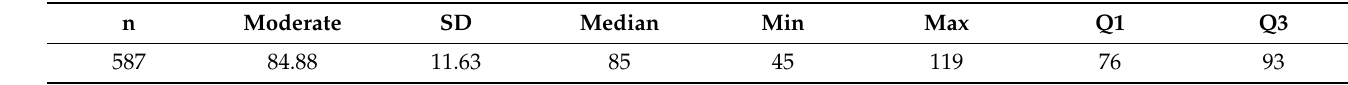
Table 3. Characteristics of Health Behavior Inventory (n = 587).